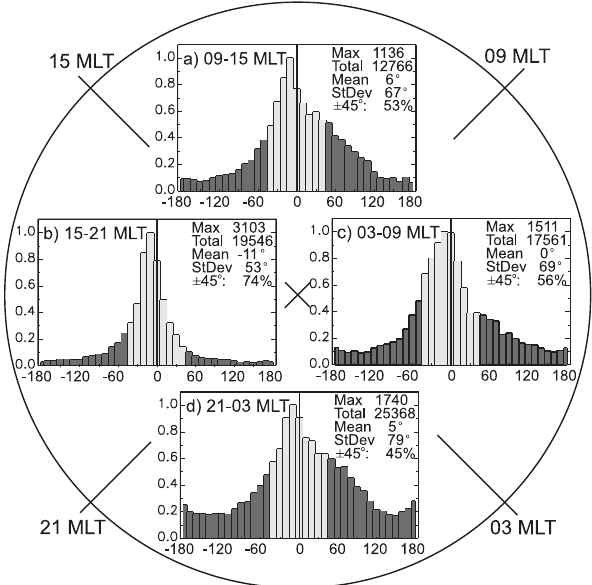
Fig. 6. Statistical distributions for the angle 1θ in four mag- netic local time sectors: (a) dayside (09:00–15:00 MLT), (b) dusk (15:00–21:00 MLT), (c) dawn (03:00–09:00 MLT) and (d) night- side (21:00–03:00 MLT). All distributions were normalized to one. Also shown are the number of points corresponding to the bin of the distribution maximum, total number of points available, the mean value of the distribution (in degrees), the standard deviation of the distribution (in degrees), and the percentage of data points with 1θ within ± 45 ◦ . Data for five days were